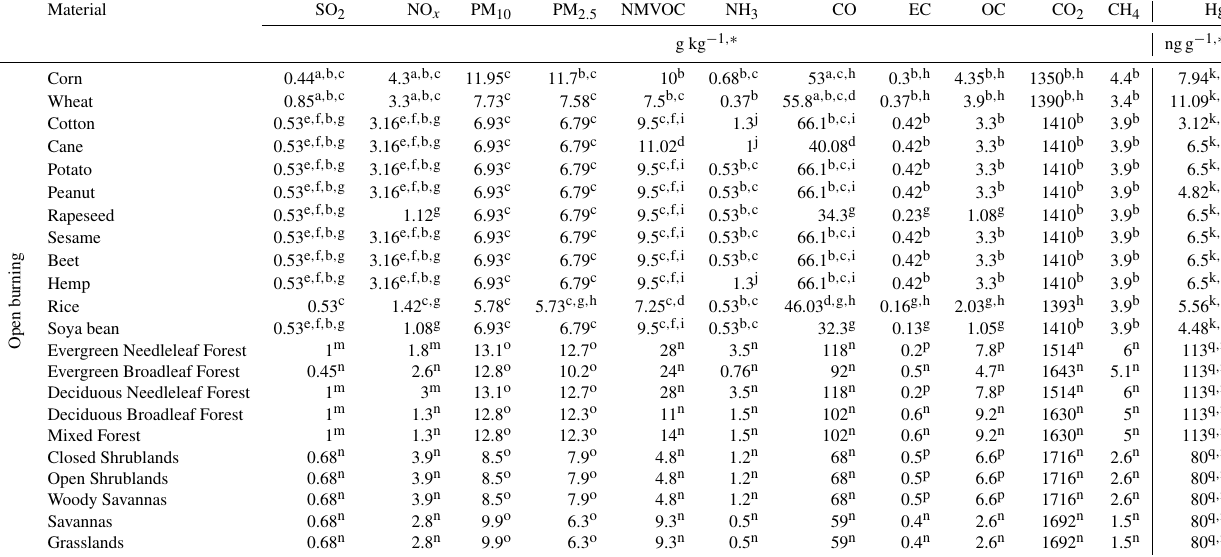
Table 6. Emission factors used in the estimation of open biomass burning